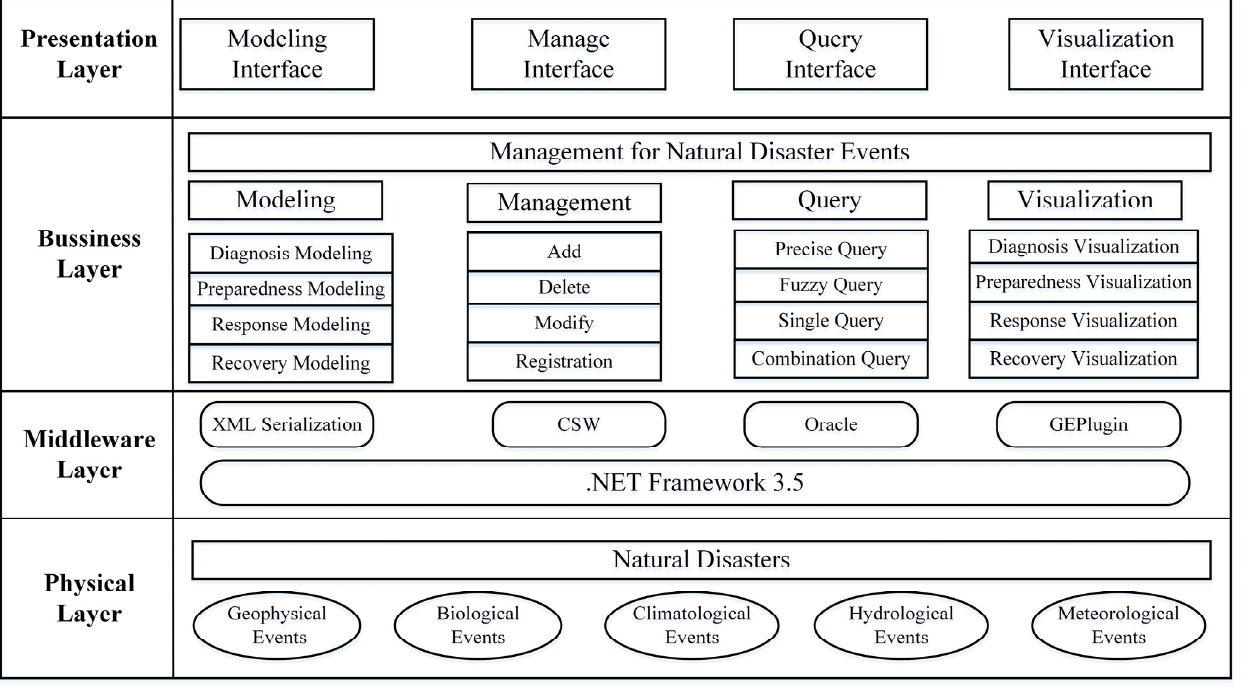
Figure 7. Architecture of the Natural Disaster Event Manager